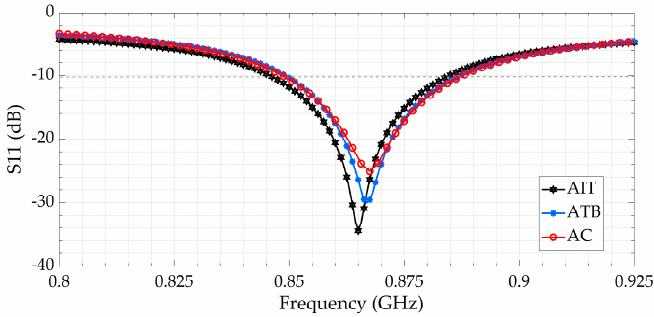
Figure 9. Comparison of the measured return loss (S11) of the D1 antenna with different feeding methods.